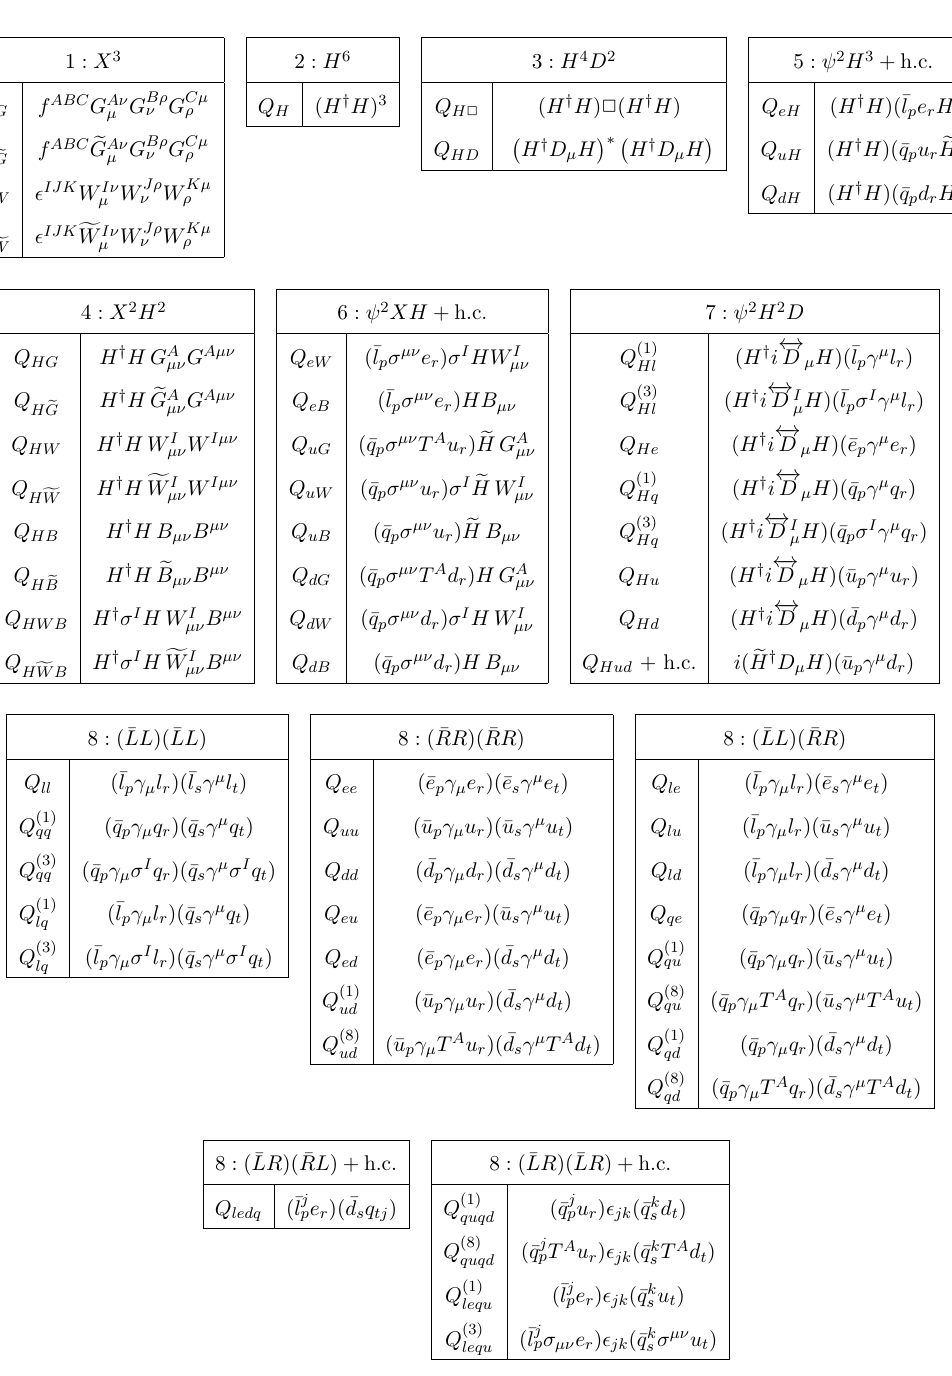
Table 3 . The 59 independent baryon number conserving dimension-6 operators built from Standard Model (cid:12)elds, in the notation of [24]. The subscripts p; r; s; t are (cid:13)avour indices, and (cid:27) I are Pauli